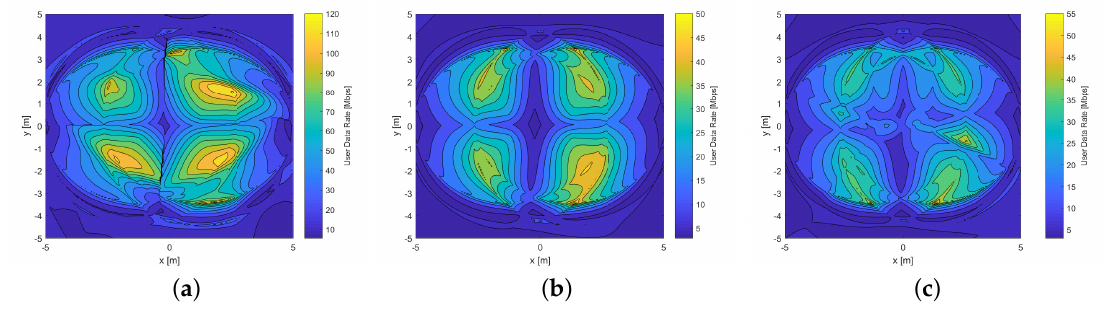
Figure 11. UDR distribution of the hemi-dodecahedron ADR in the mine working face scenario: ( a ) MRC, ( b ) EGC, and ( c ) SBC